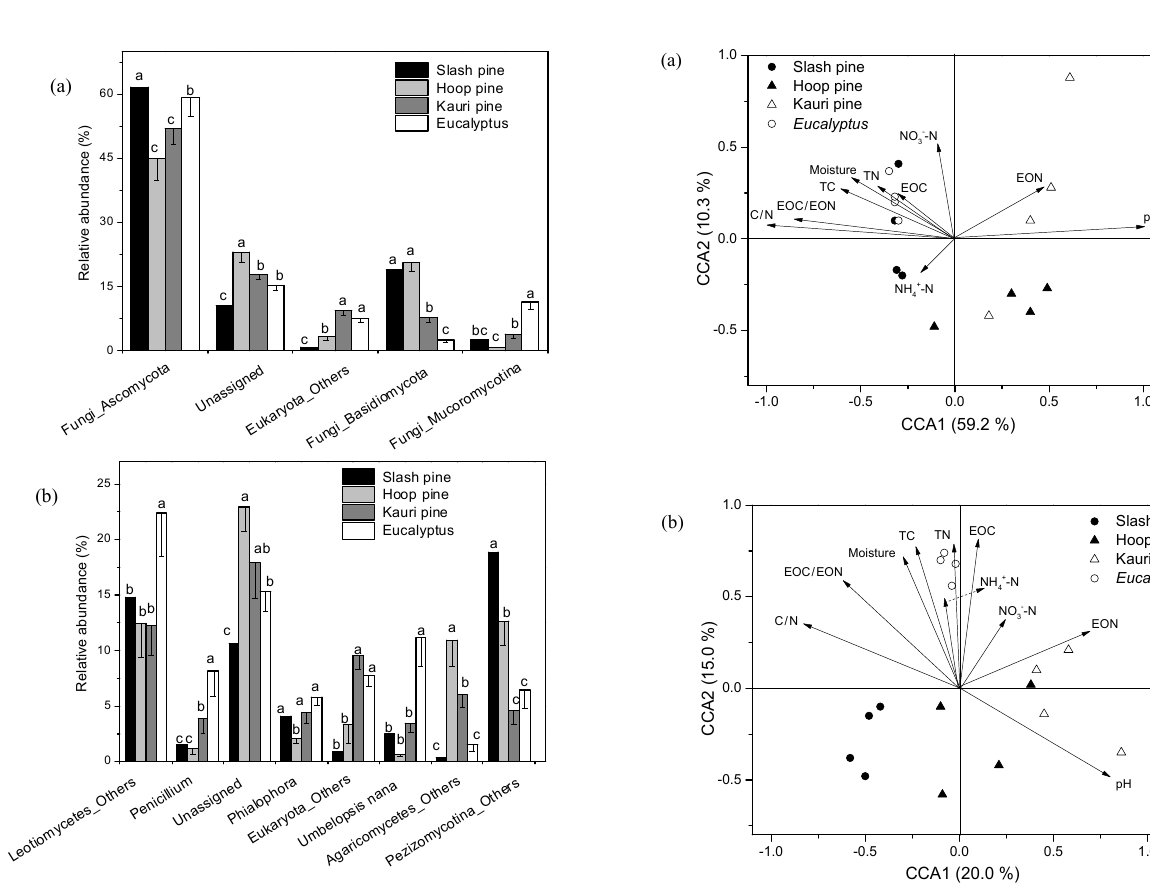
Figure 4. Canonical correlation analysis (CCA) of the relationships between soil physiochemical properties and bacterial (a) and eu- karyotic (b) communities under different tree